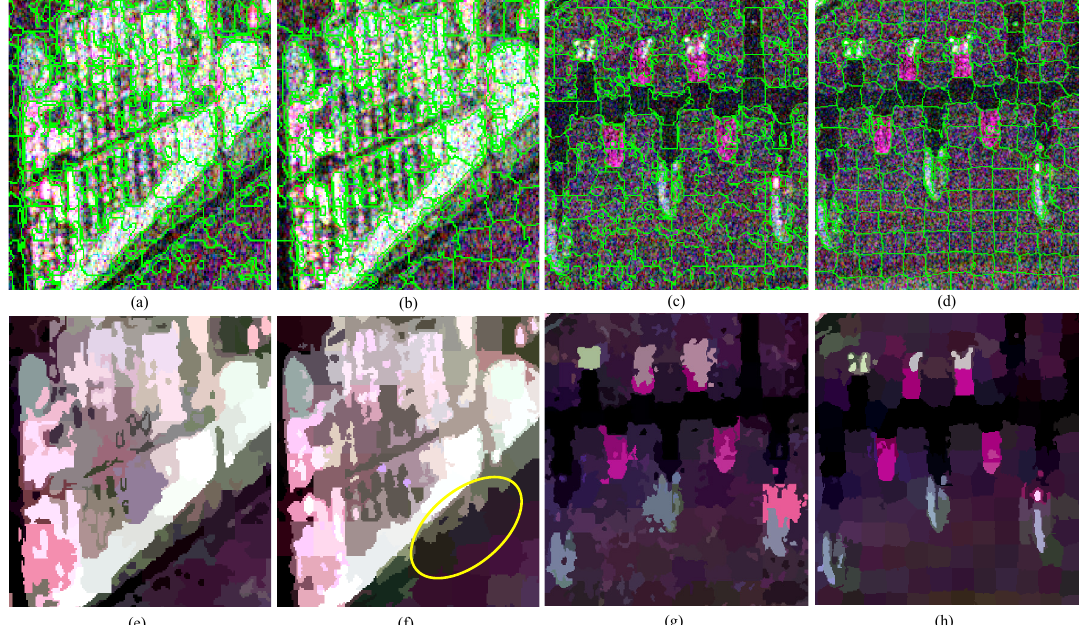
Fig. 4. Comparison of detailed superpixel generation results in area A and B. The first row denotes the final superpixel maps. The green lines superimposed onto the Pauli images depict the superpixel boundaries. The second row gives the corresponding representation maps. (a) and (b) are the results of area A in Fig. 3 (c) and (e), respectively. (c) and (d) are the results of area B in Fig. 3 (c) and (e), respectively.